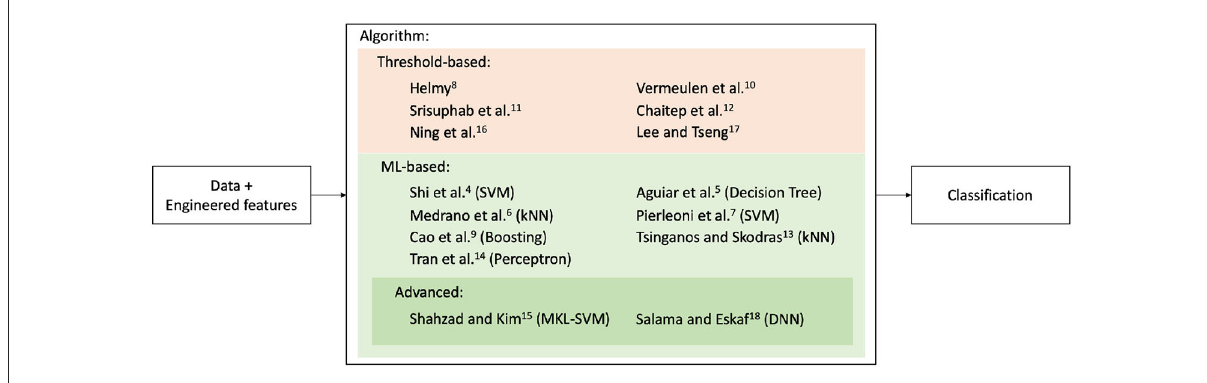
FIGURE7 Categorization of algorithms for selected studies between threshold and ML-based. ML-based approaches constitute the majority.